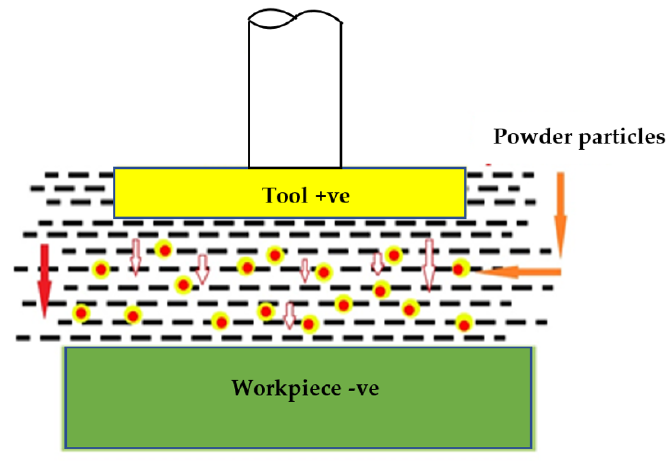
Figure 5. Schematic representation of the principle of powder-mixed EDM.